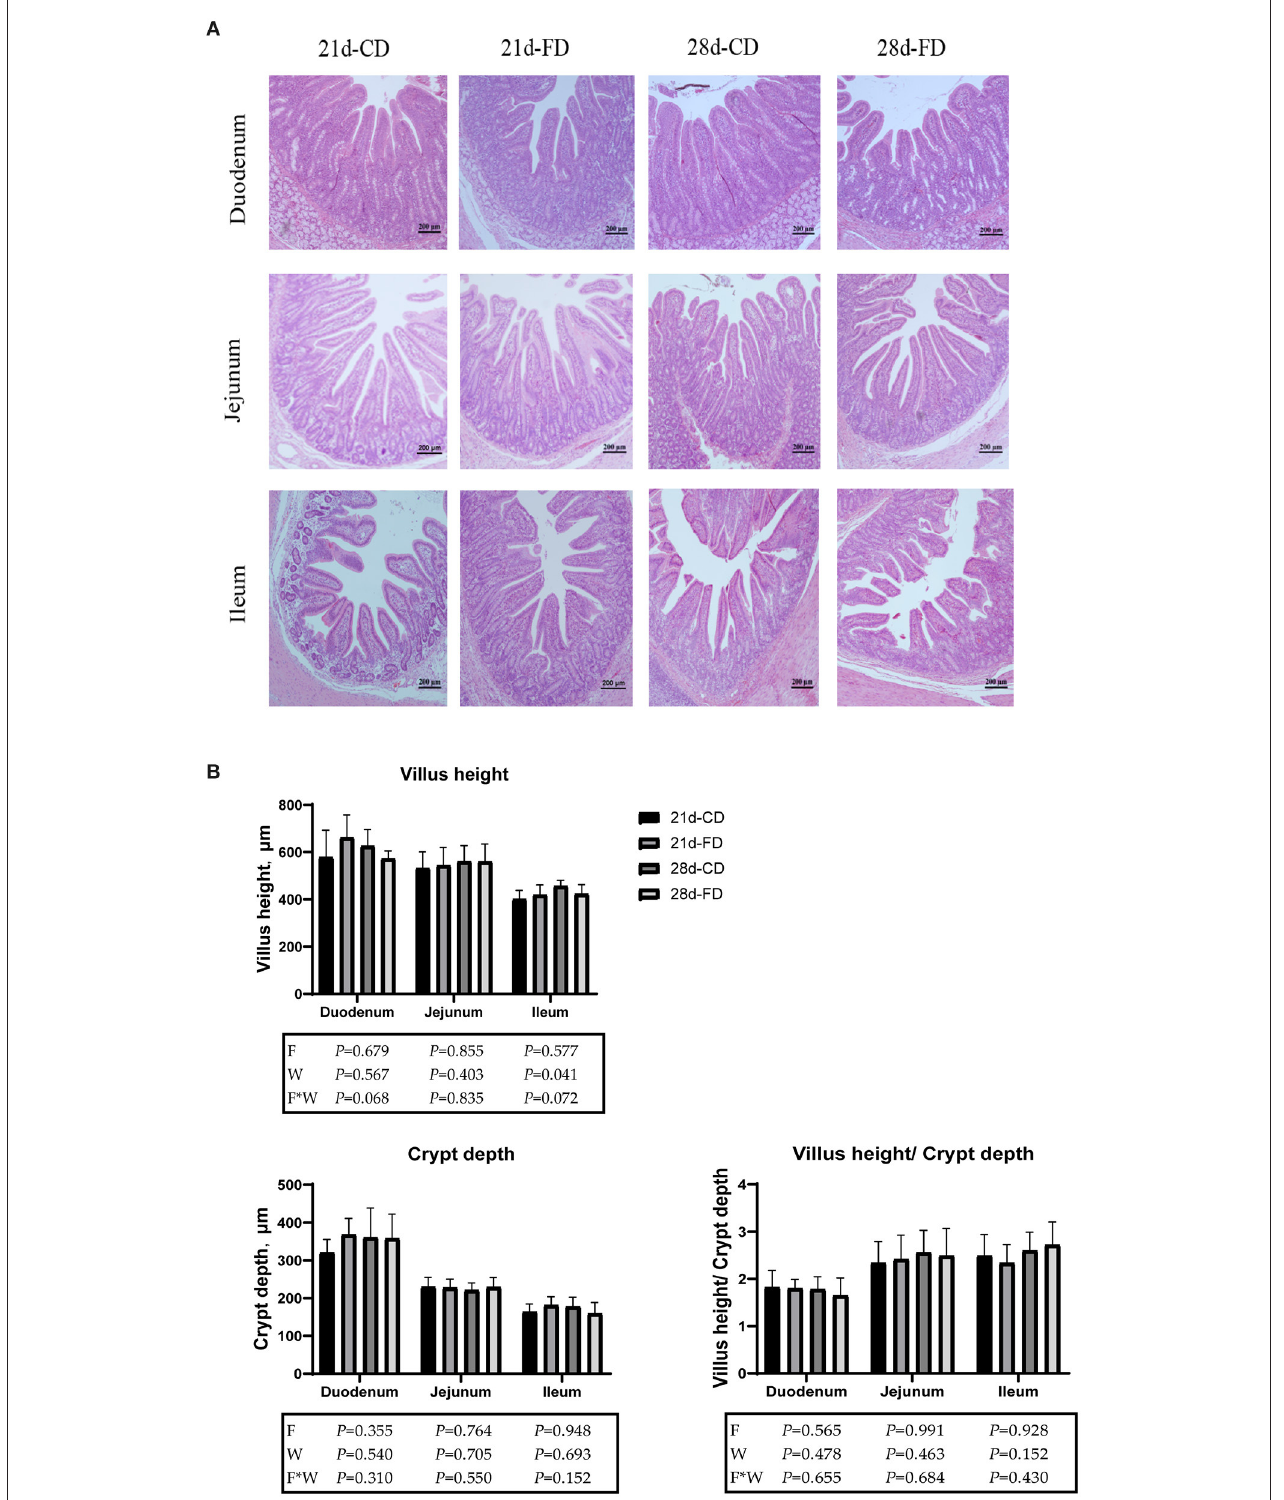
FIGURE 3 | Hematoxylin-eosin staining photos of the duodenum, jejunum, and ileum (magnification ' × 200). (A) The duodenum, jejunum, and ileum by H&E-staining (scale bar 200 µ m). (B) Villi height, crypt depth and villi height/crypt depth in duodenum, jejunum and ileum. 21d-CD, 21-day-old weaned piglets fed the control diet. 21d-FD, 21-day-old weaned piglets fed the fermented diet. 28d-CD, 28-day-old weaned piglets fed the control diet. 28d-FD, 28-day-old weaned piglet fed the fermented diet. F, the main effect of fermented diet. W, the main effect of weaning age. F*W, the interaction effect between fermented diet and weaning age. Values are presented as the mean ±